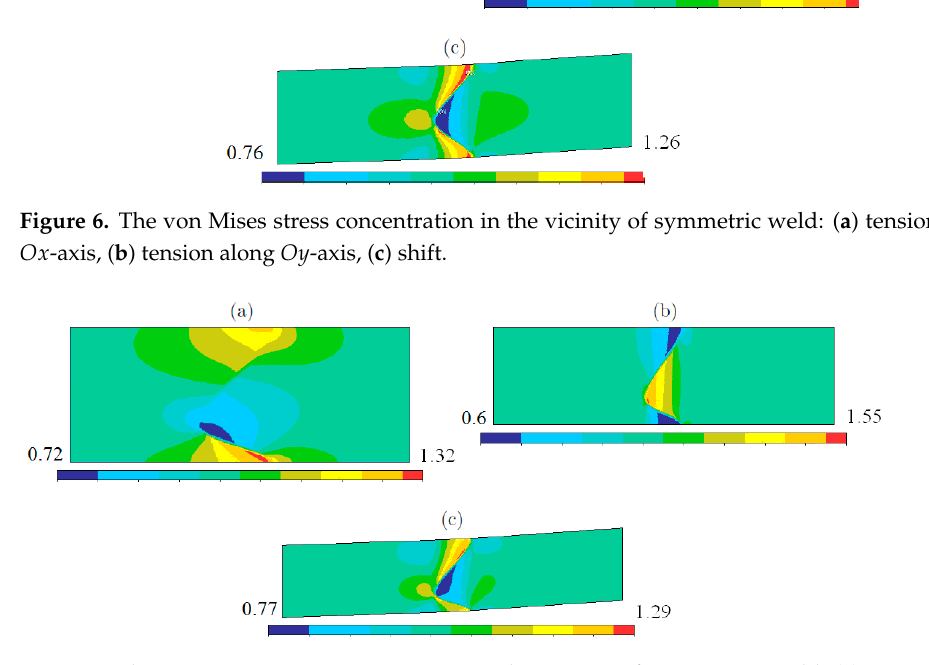
Figure 7. The von Mises stress concentration in the vicinity of asymmetric weld: ( a ) tension along Ox -axis, ( b ) tension along Oy -axis, ( c ) shift.